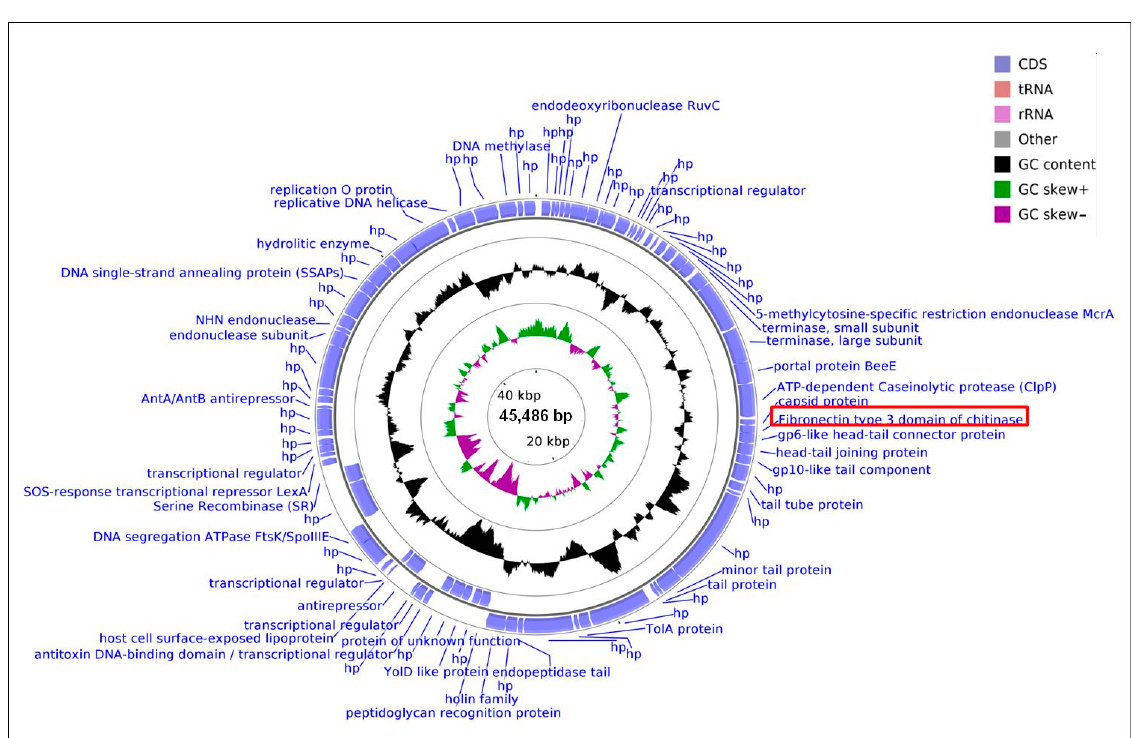
Figure 5. Genome structure of Bacillus bacteriophage created by using the BRIG platform and the CGView program. The outermost ring presents open reading frames (ORFs) with predicted annotations (blue arrows). The middle ring shows the GC content (black). The innermost ring represented GC skew+ (green) and GC skew − (purple). The ORF26 that potentially encodes the protein containing fibronectin type 3 domain, characteristic for/to chitinase, is indicated by the red frame.